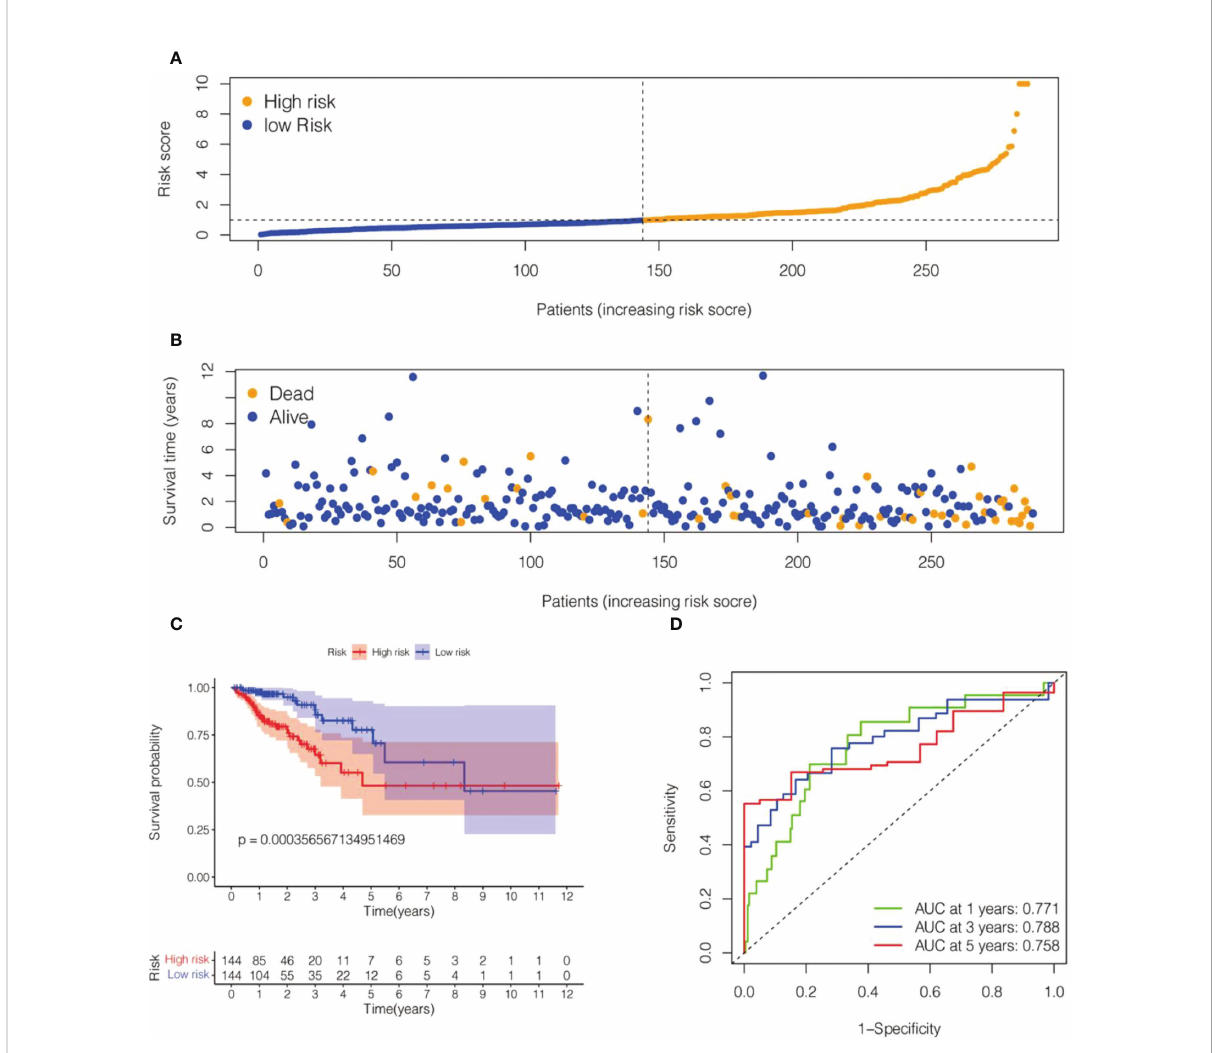
FIGURE 3 Risk model for 6 cell senescence-related lncRNAs with prognostic value in the TCGA training set. (A) Distribution of risk scores and different groupings in the TCGA training set. (B) Relationship between risk score and survival status in the TCGA training set. (C) Kaplan – Meier survival analysis of the high-risk and low-risk groups in the TCGA training se. (D) Time-dependent ROC curve depicting the predictive accuracy of the risk model for OS in the TCGA training